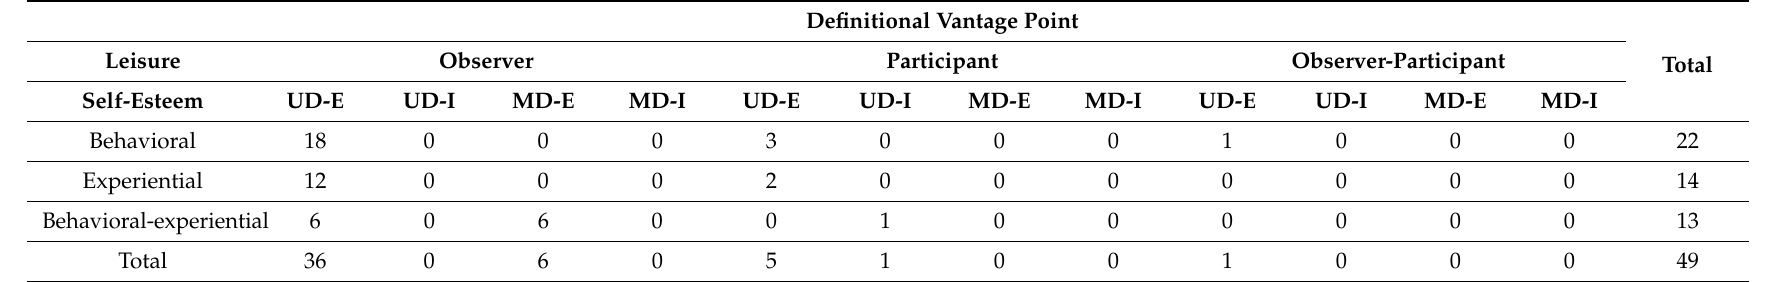
Table 4. Research approaches in the study of the relationship between leisure and